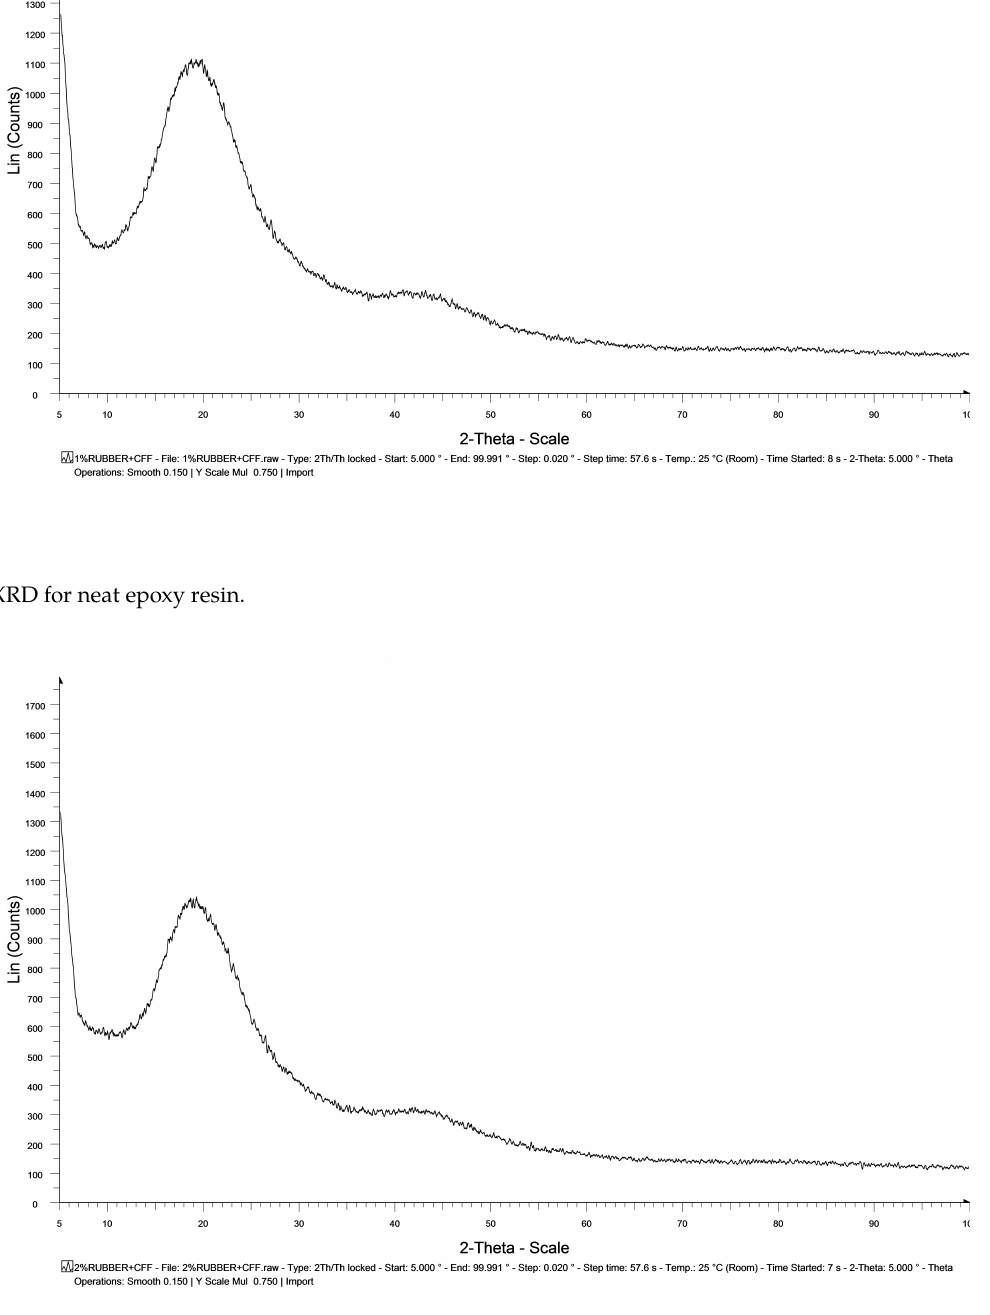
Figure 28: XRD for the sample containing 0.5 wt% CR and 5.0 wt%